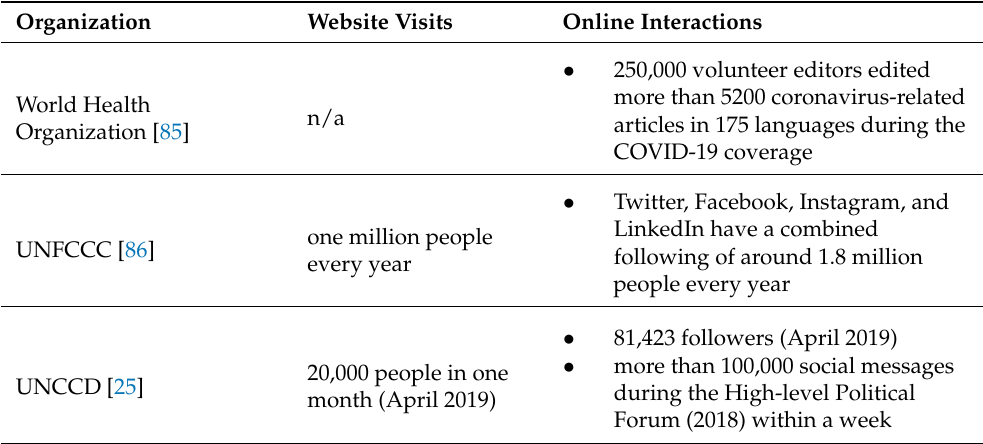
Table 5. Selected UN-based organizations and their website